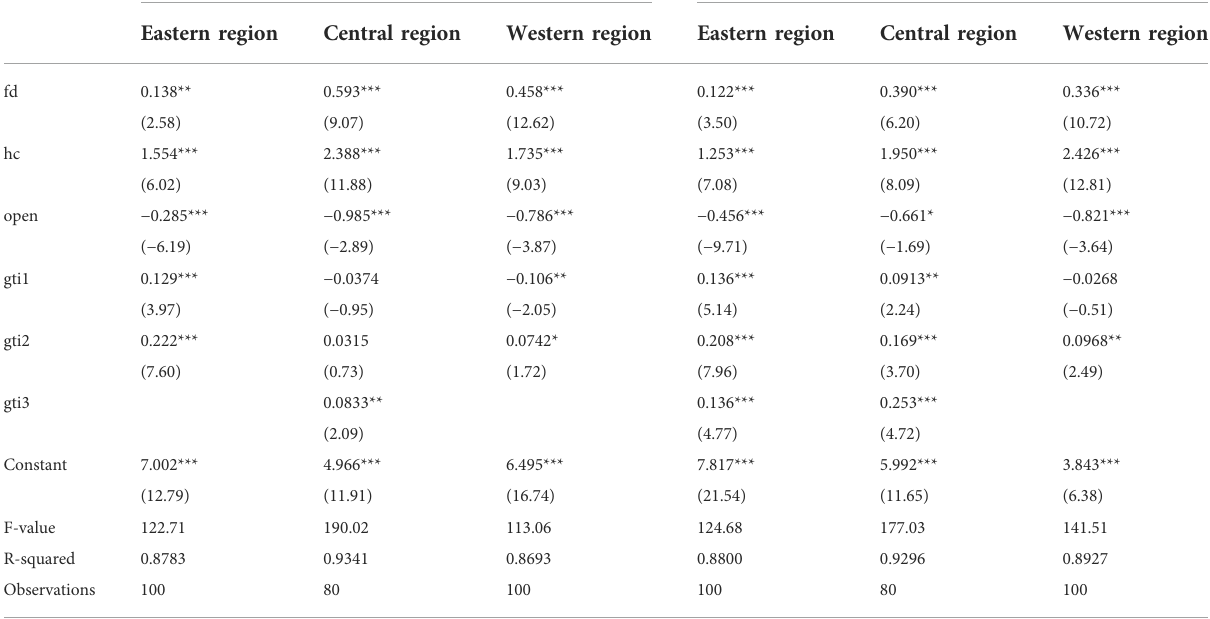
TABLE 10 Regional threshold model estimation results.